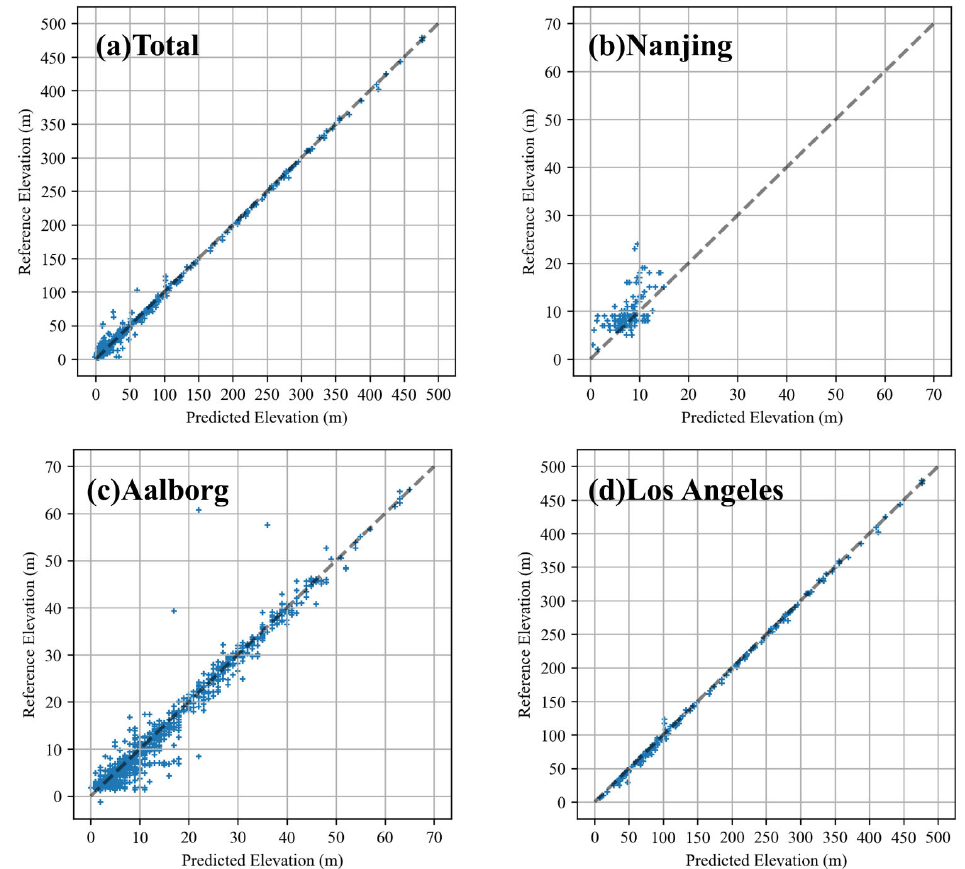
Figure 7. Road elevation validation with multi-source data (reference road elevation) in three re ‐ gions. ( a ) Total of the three cities ( b ) Nanjing; ( c ) Aalborg; ( d ) Los Angeles.